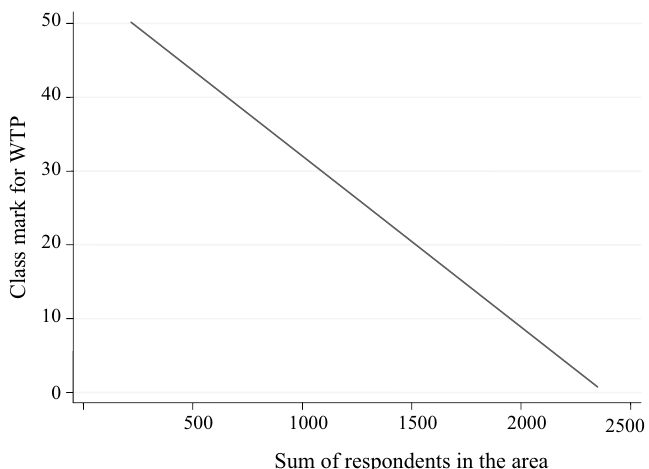
Fig. 1 Projected demand curve for the conservational benefits of Gedo Natural Forest. Source: Own design,